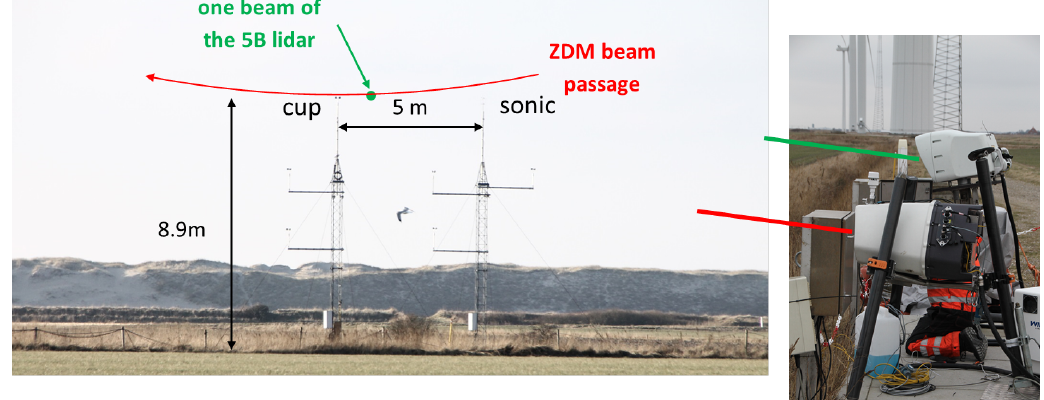
Figure 6. Schematic of the beam positions of the 5B ( green ) and ZDM ( red ) lidars at DTU Wind Energy test site,